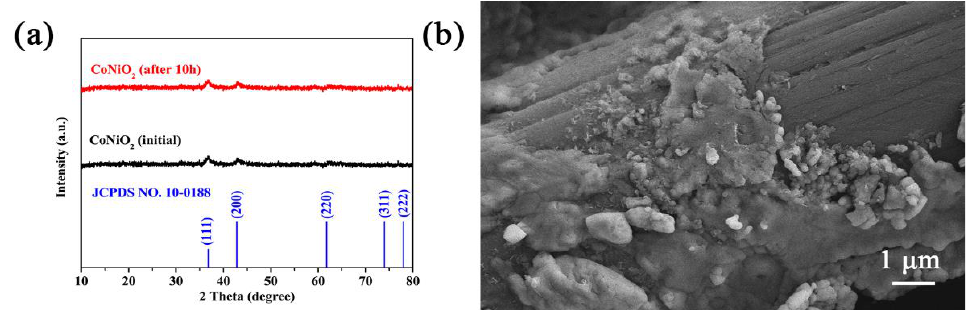
Figure 8. ( a ) XRD patterns of before and after a 10 h test of CoNiO 2 in an alkaline electrolyte. ( b ) SEM images of after a 10 h test of CoNiO 2 in an alkaline electrolyte. As shown in Figure 9a, the characteristic peak of the cobalt-nickel precursor located at 9.5 ◦ corresponds to the (001) planes of Co(OH) 2 (JCPDS No. 51-1731), and is located at 19.3° (001) planes of Ni(OH) 2 (JCPDS No. 14-0117). As shown in the SEM image (Figure 9a,b), the cobalt-nickel precursor presents the flower-like microsphere structure.